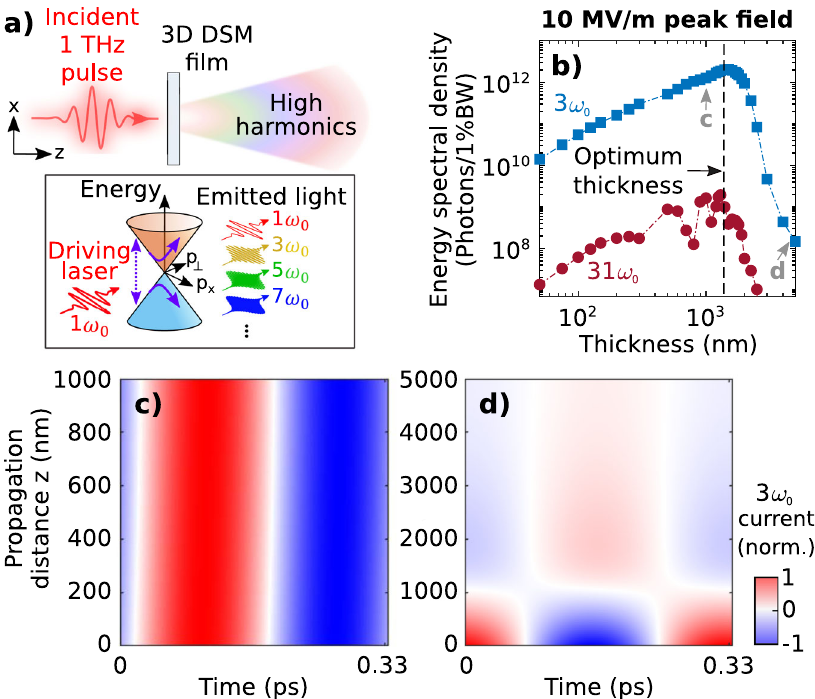
Fig. 1 Propagation-induced limits on HHG in 3D Dirac semimetals (DSMs). a An x -polarized laser pulse centered at angular frequency 1 THz impinges on a 3D DSM thin fi lm at normal incidence, resulting in the radiation of higher harmonics. In momentum space p ¼ ð p ? ; p x Þ (inset), the driving fi eld induces intraband carrier oscillations (solid purple arrows) within and interband carrier transitions (dotted purple arrow) between the valence and conduction bands of the Dirac cone, resulting in the emission of light peaked at odd-integer multiples of the input angular frequency ω 0 . b shows orders-of-magnitude enhancements in output intensity with increasing fi lm thickness up to an optimal value of about 1500 nm, beyond which the harmonic output drastically falls. The existence of an optimal thickness arises due to the propagation-induced phase shift of the harmonic current (normalized 3rd harmonic current plotted in c , d ) for 1 μ m and 5 μ m) across the fi lm thickness. In thinner fi lms c the phase shift in the current as a function of propagation distance z is insigni fi cant. Thus, the emitted waves from different z are in-phase and add constructively. For fi lms much thicker than the optimal thickness d a π -phase- fl ip occurs in the current density. The emitted radiation from opposite sides of this phase fl ip destructively interfere, resulting in the drastic decrease in HHG output with increasing fi lm thickness seen in ( b